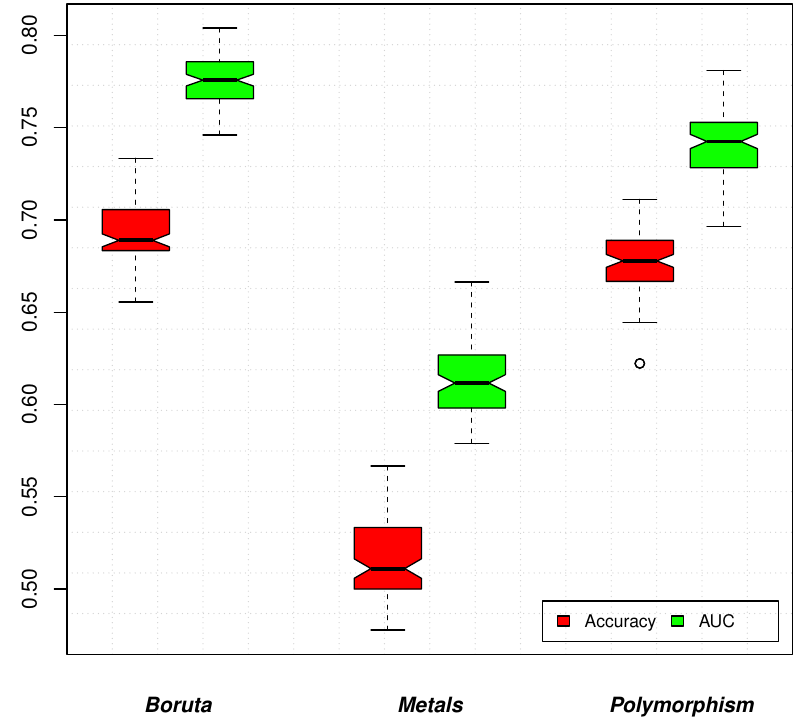
Figure 7. Accuracy and AUC values for 3 different RF models. The first classifier has been fed with the features selected by Boruta; the second with 27 heavy metals concentrations; the third with 25 polymorphisms. Each distribution was computed through a LOO cross validation procedure repeated 100 times. Empty bullets represent the outliers of